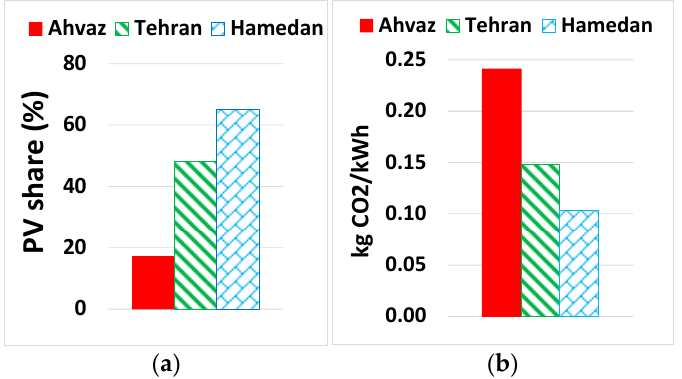
Figure 10. Share of solar PV units ( a ) and specific CO 2 emission factor ( b ).